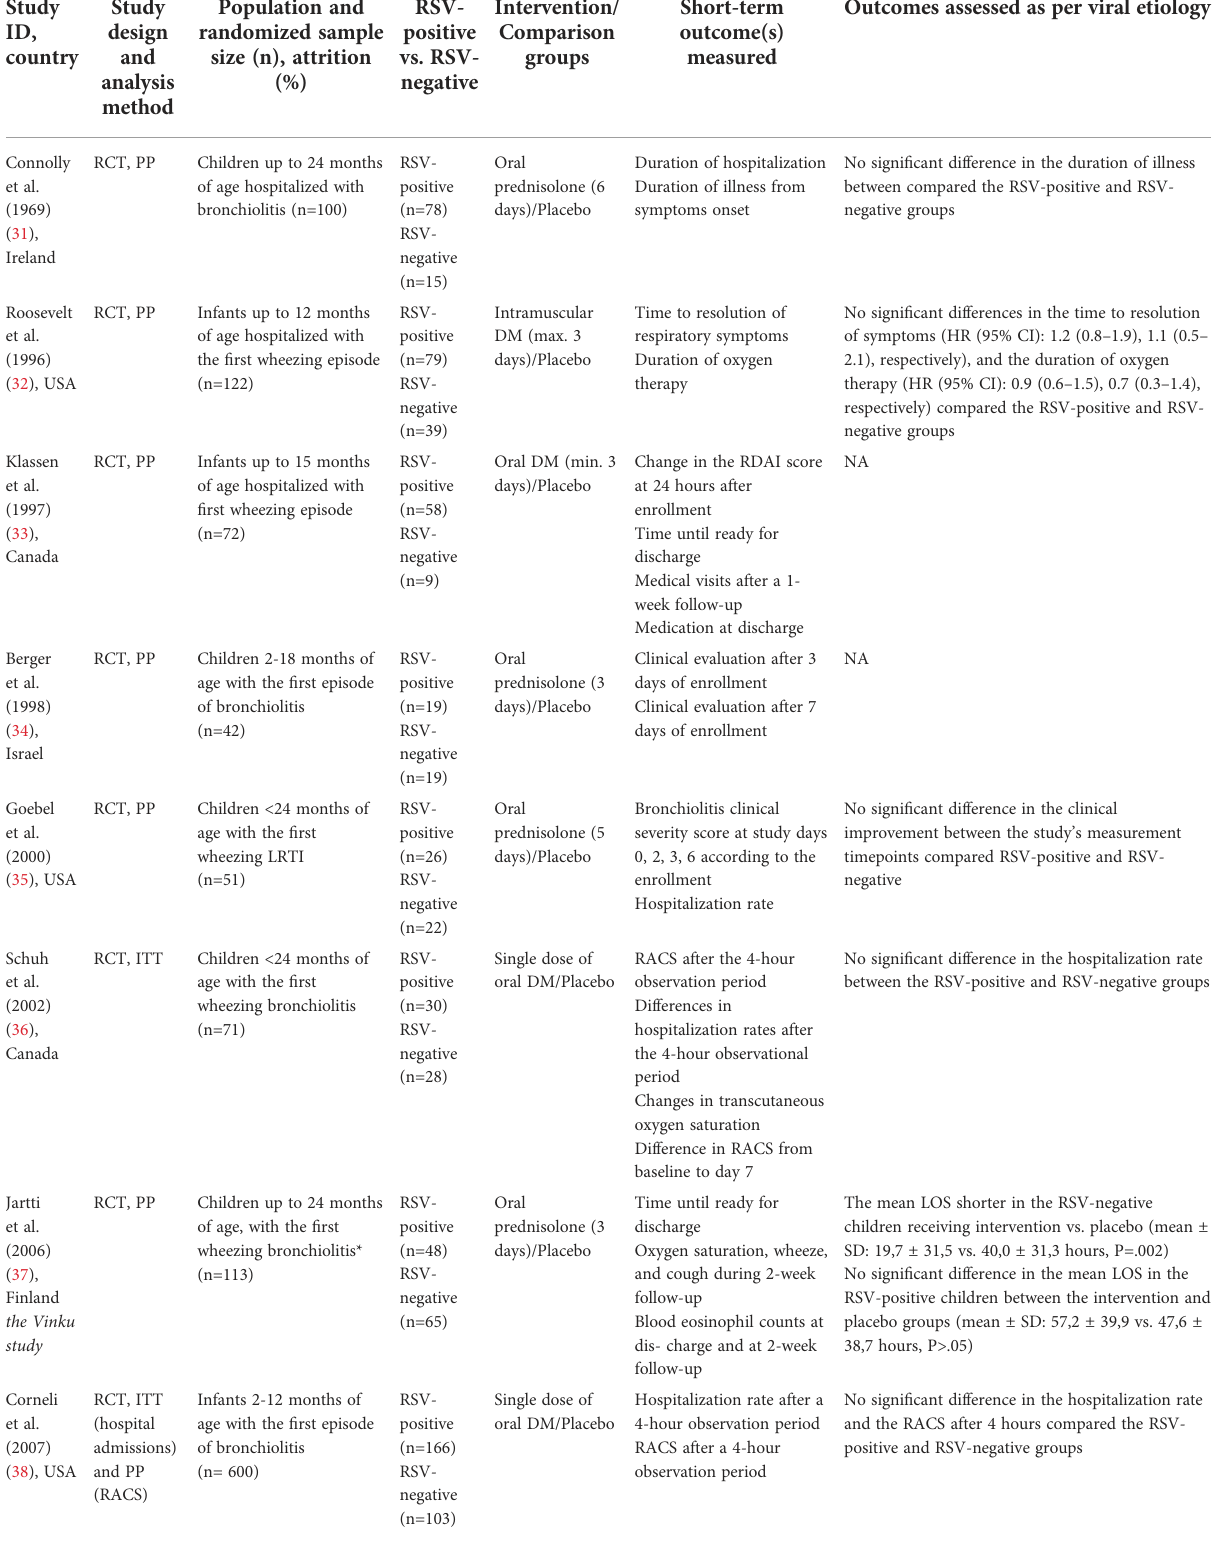
TABLE 1 Characteristics of the included studies in the magnitude of short-term outcome assessment. Study